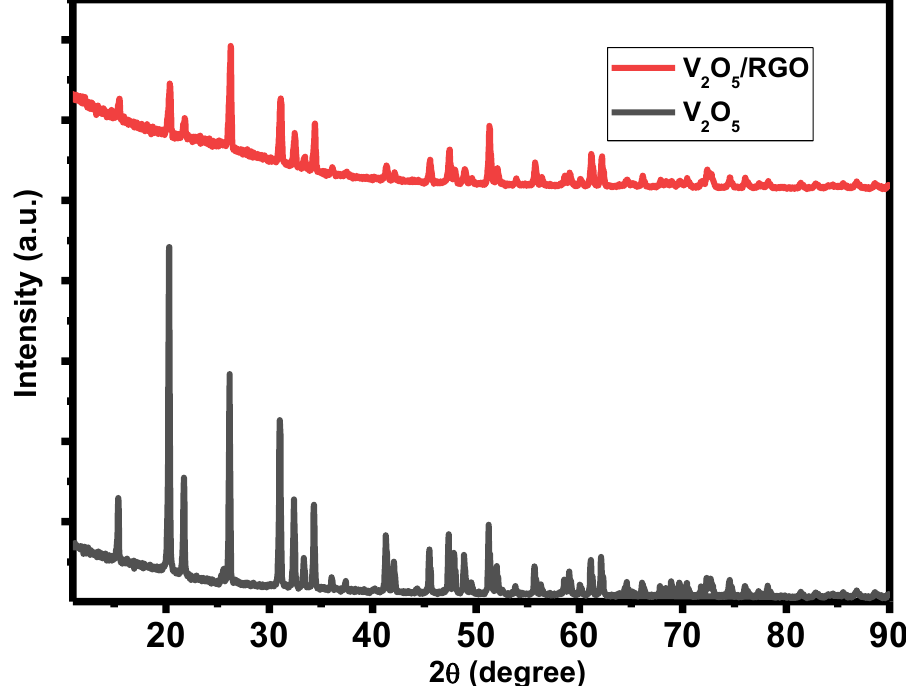
Figure 1. X-ray diffraction patterns of V 2 O 5 and V 2 O 5 /RGO composite. Raman spectroscopy was used to study the structure, symmetry and types of bond- ing in the V 2 O 5 and V 2 O 5 /RGO composite. Figure 2 presents the Raman spectroscopic study of the V 2 O 5 and V 2 O 5 /RGO composite. The V 2 O 5 Raman spectrum exhibits multiple peaks, which are located at 144.23, 197.32, 283.05, 404.12, 482.16, and 528.75 cm −1 . The low- frequency peak observed at 144.23 cm −1 corresponds to the B3g bending mode of vibra- tion. The bending vibration of O – V – O corresponds to the peak at 197.32 cm −1 , while the peaks at 283.05 and 404.12 cm −1 correspond to the oscillating Ag mode of V = atoms O. The peaks at 482.16, and 528.75 cm −1 are due to the vibration mode Ag of (V – O 3 –V) and ν(d3) , respectively [22,23]. In the case of V 2 O 5 /RGO, two extra Raman peaks were detected at 1350.56 and 1582.85 cm −1 , as compared to V 2 O 5 [24]. The peak at 1350.56 cm −1 corresponds to the D band and the peak at 1582.85 cm −1 corresponds to the G band, which confirms the presence of RGO in the V 2 O 5 /RGO composite. The G band arises due to the bond stretch- ing of sp 2 carbon pairs in both rings and chains, and this band is associated with the optical E2g phonons at the Brillouin zone center. The D band, associated with the bending mode of aromatic rings, arises due to defects in the sample; the degree of disorder was also measured using the intensity of the D band [25].